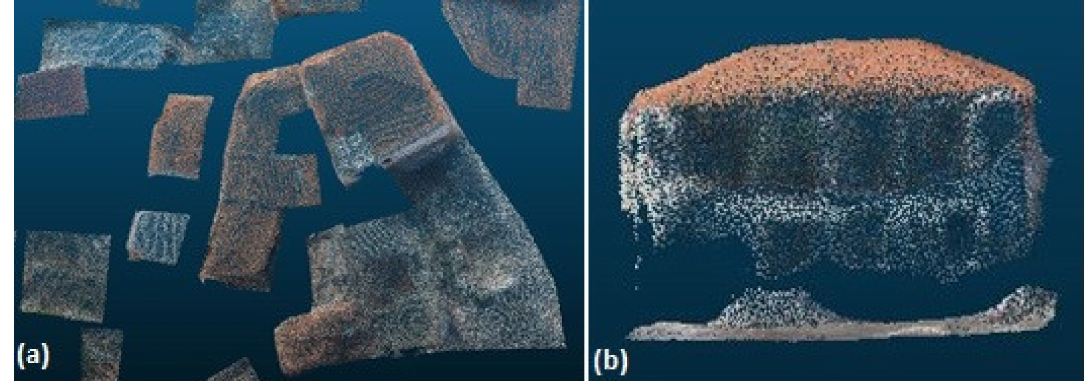
Figure 7. ( a ) Part of the 3D point cloud of 3rd February 2019 derived from UAS 4K-video footage and ( b ) combination of two point clouds: (i) top 25th July 2017 presents a damaged building; (ii) bottom 3rd February 2019 presents the ground after the